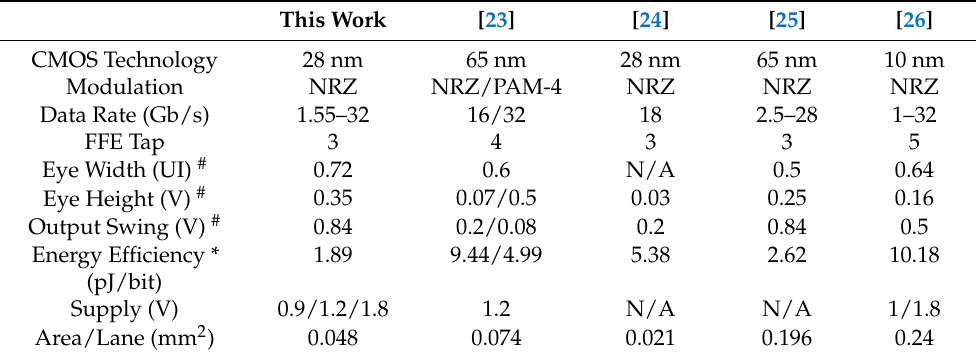
Table 1. Performance summary and